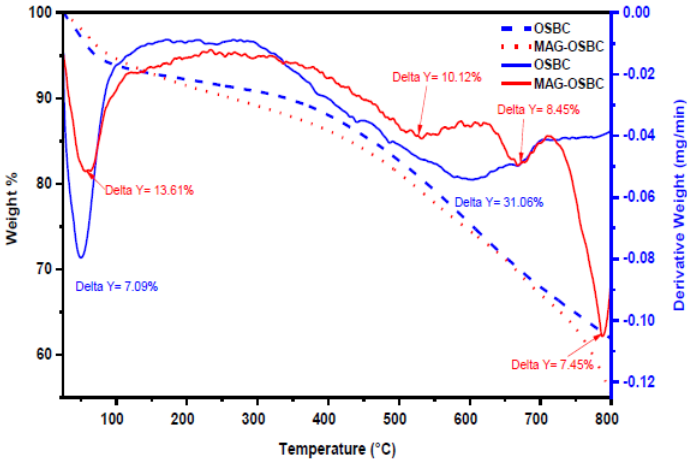
Figure 1. TGA/ d TA analysis of olive stone biochars (OSBC) and magnetic olive stone biochar